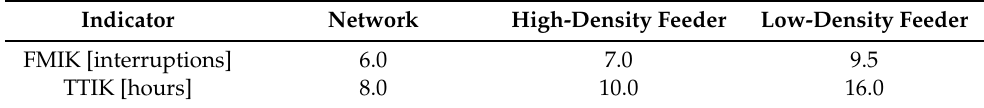
Table 8. Continuity limits for global indicators in Ecuador.